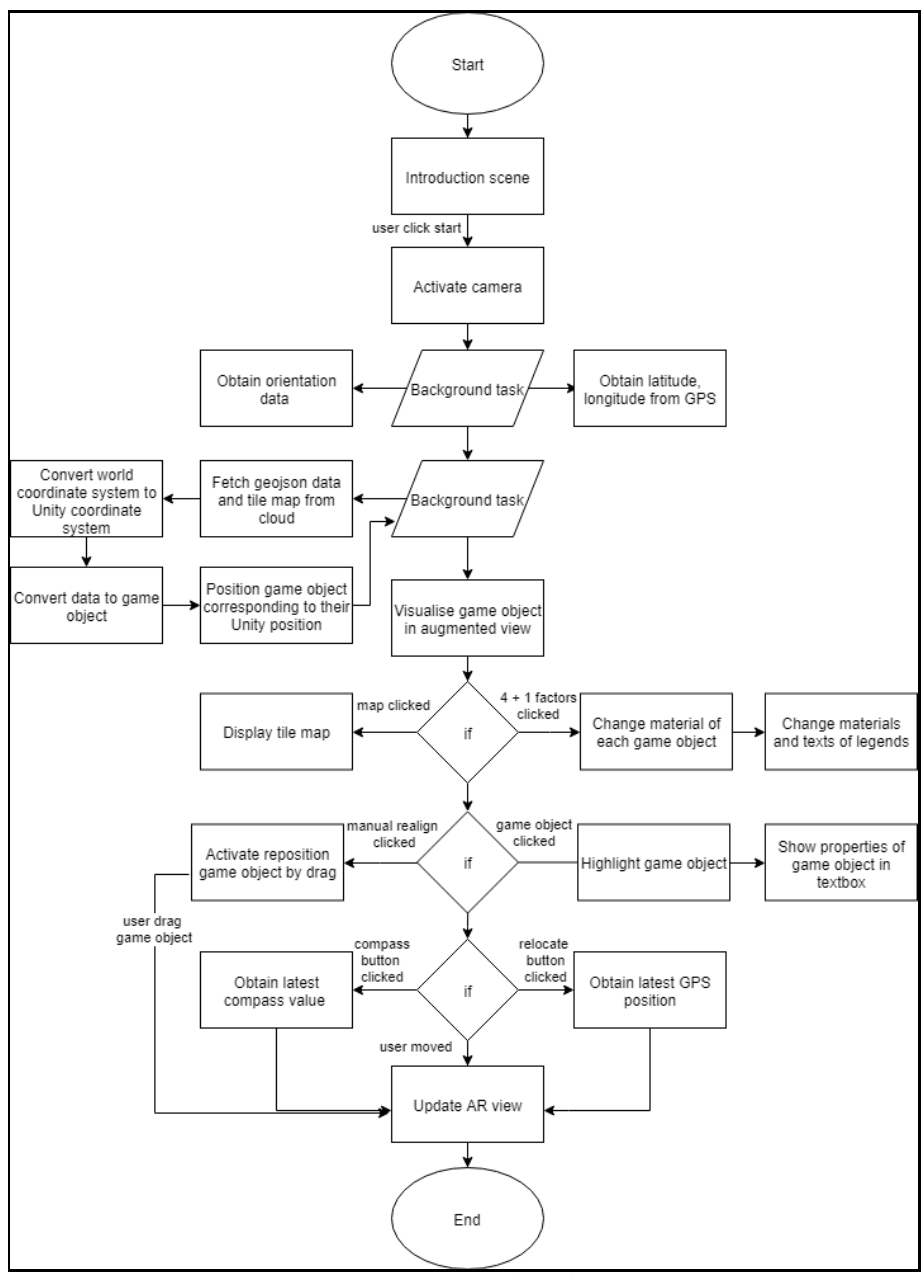
Figure 2. Detailed workflow of